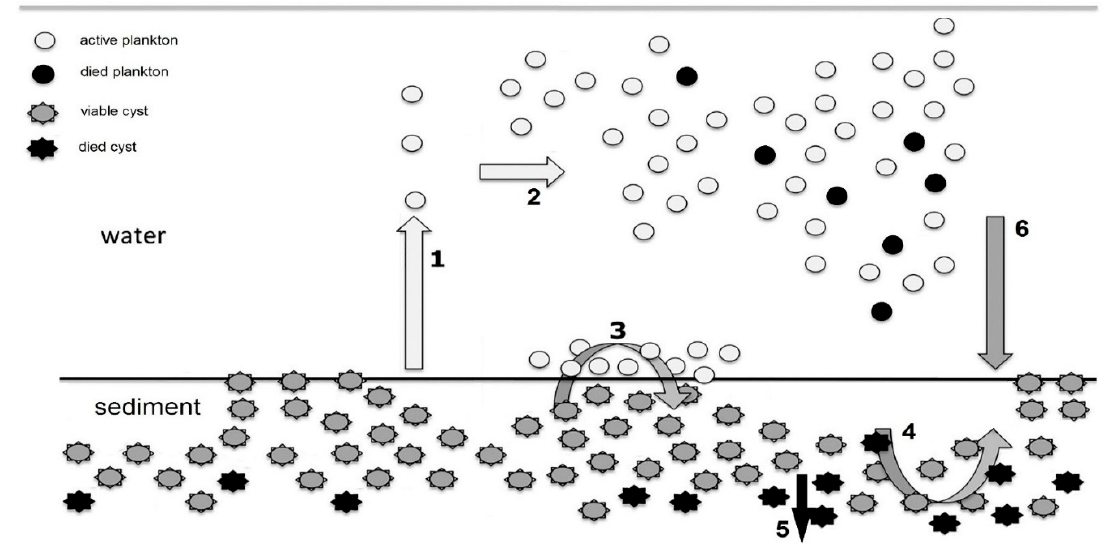
Figure 1. A schematic diagram of the dynamic interactions of plankton between active life in the water column and rest in sediment cyst bank. ( 1 ) Subtraction in favor of water column (germination); ( 2 ) multiplication of active stages; ( 3 ) tight and fast supply-removal (encystment–germination) from/to hyperbenthos; ( 4 ) mixing within the bottom cyst bank as a consequence of sediment re-working; ( 5 ) subtraction due to death; and ( 6 ) cysts supply from plankton (encystment).